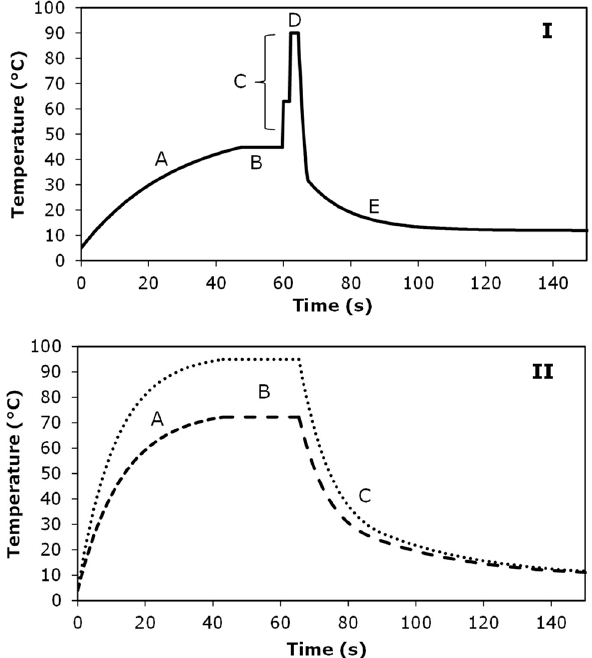
Figure 1. Example of temperature-time profile of the moderate intensity PEF treatment ( I ) and thermal treatment ( II ) of orange juice. Panel ( I ). Orange juice was preheated from 4 °C to 45 °C in 48 s (A), maintained at 45 °C for 12 s (B) before entering the treatment chambers, heated up in the first treatment chamber, followed by a pause of 1.7 s, the time to go to the second treatment chamber, and heated up to a desired maximum temperature, i.e., 90 °C (C). Then orange juice is transferred to cooling section in 2.3 s (D) and cooled down for 122 s to temperatures < 10 °C ©. Panel ( II ) . Orange juice was preheated from 4 °C to 72 °C for low thermal treatment or to 95 °C for high thermal treatment in 43 s (A), maintained at the desired temperature for 20 s (B) and cooled down for 113 s to temperatures < 10 °C (C).